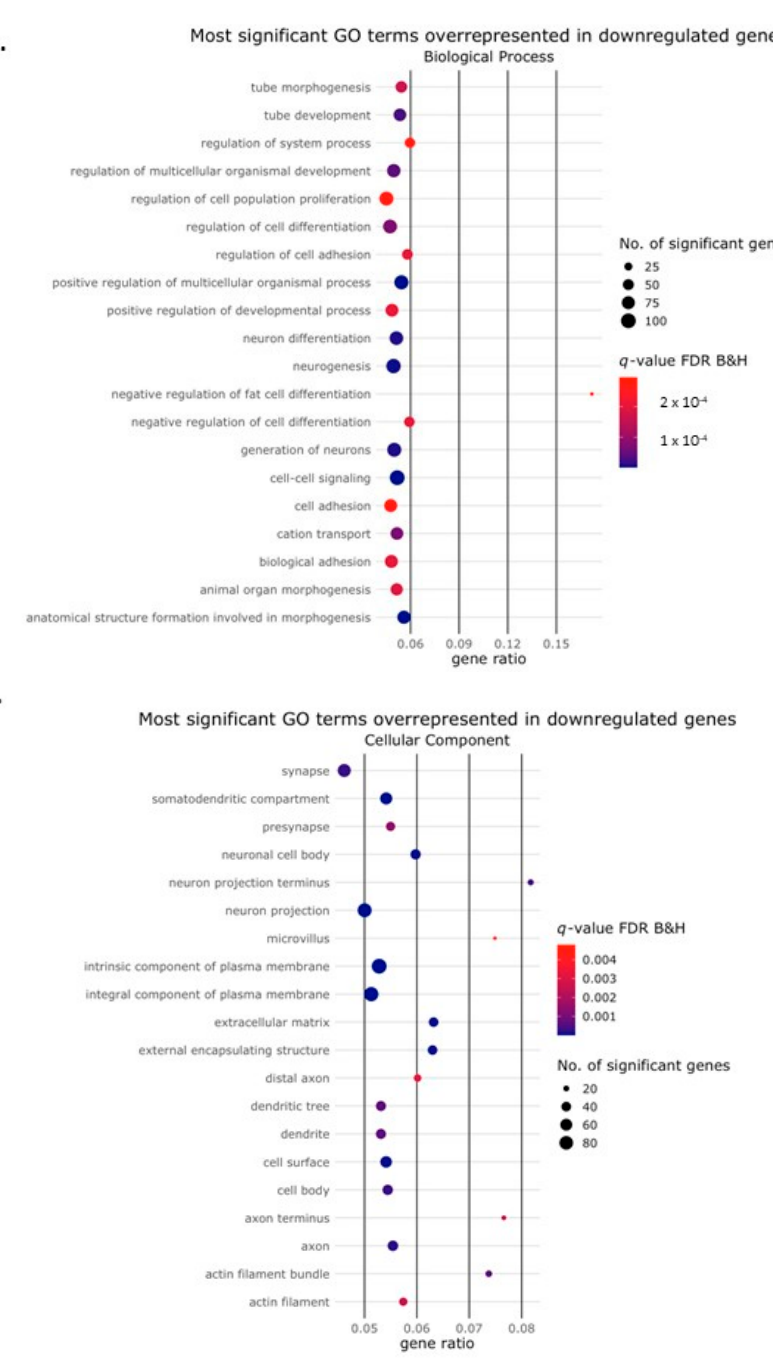
Figure 4. Gene Ontology terms enriched among the downregulated genes. Bubble plot showing the Gene Ontology (GO) terms that were enriched among the genes downregulated by the Activin-A treatment. The size of the circle represents the number of DEGs ( p (adj) < 0.01, Log2 fold change ≥ 2) in that pathway. The color of the circle represents the significance depicted as a q-value, with the default settings of the Benjamini–Hochberg false discovery rate (FDR B&H). The gene ratio represents the ratio between the number of DEGs in our dataset and the total number of genes in that GO category. The top 20 most significant GO terms were enriched in ( A ) the molecular function domain (only 13 GO terms in this domain were found to be enriched), ( B ) the biological process domain and ( C ) the cellular component domain.